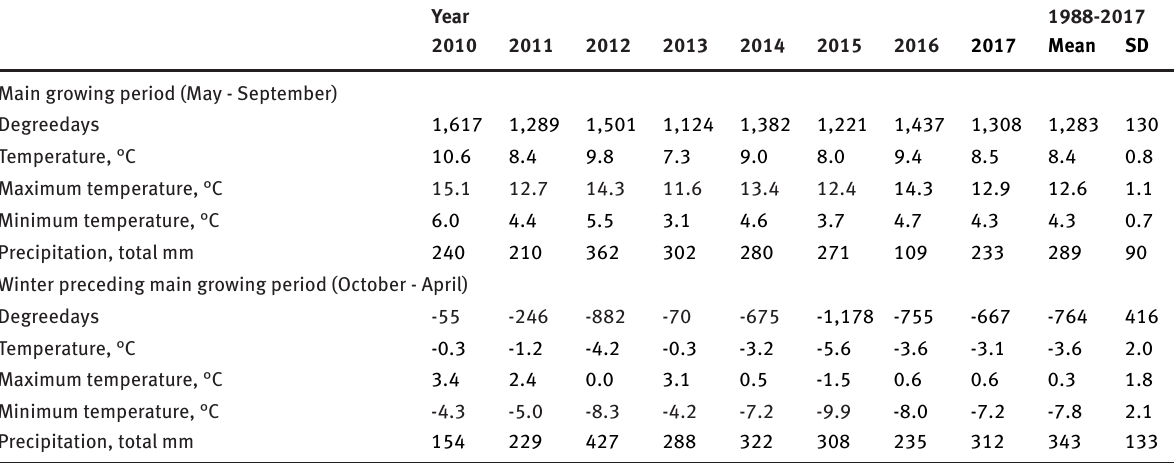
Table 4: Selected climate data¹ for Narsarsuaq² in southern